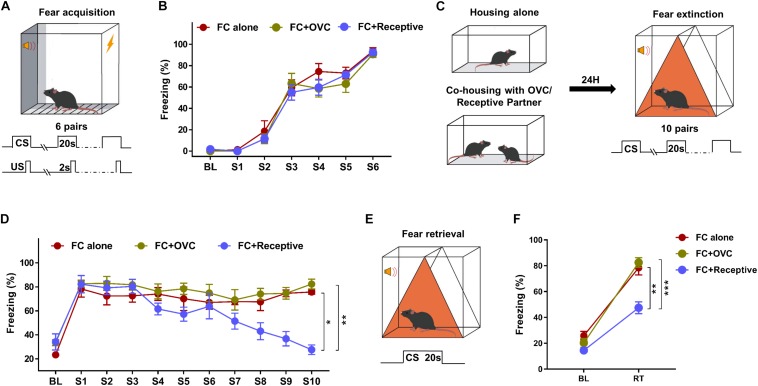
Social company by a receptive mating partner facilitates fear extinction. (A) Schematic of the tone-cued fear conditioning procedure. Six pairs of US (Foot shock, 0.7 mA, 2 s)–CS (tone, 20 s) were delivered during fear condition training. (B) A robust freezing response was elicited by the CS during fear conditioning. n = 8 mice for each group. BL, baseline; S, tone. (C) Diagram of co-housing design and schematic of the tone-cued fear extinction training. CSs were delivered 10 times with an interval time of 90 s. (D) Gradually reduced freezing level of male mice in the “FC + Receptive” group. n = 8 mice for each group. One-way ANOVA: ***P < 0.001. Repeated two-way ANOVA, group effect: “FC + Receptive” vs. “FC alone”, ∗P = 0.0184; “FC + Receptive” vs. “FC alone,” ∗∗P = 0.0016. (E) Diagram of extinction retrieval test. Freezing time was recorded in the absence and presence of CS. (F) Freezing level was decreased in male mice in the “FC + Receptive” group in retrieval test. n = 8 for each group. Student’s t-test: “FC + Receptive” vs. “FC alone,” **P = 0.001; “FC + Receptive” vs. “FC alone,” ***P < 0.001.